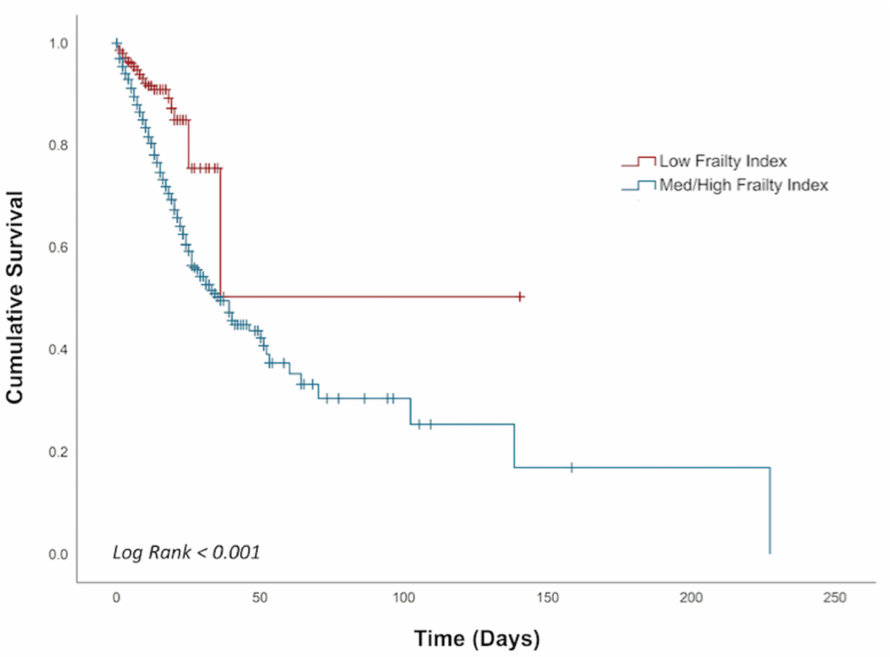
Figure 1. Kaplan–Meier estimation in determining the impact of frailty on in-patient mortality. Table 4. Adjusted Cox regression model showing the impact of frailty on the risk of in- patient